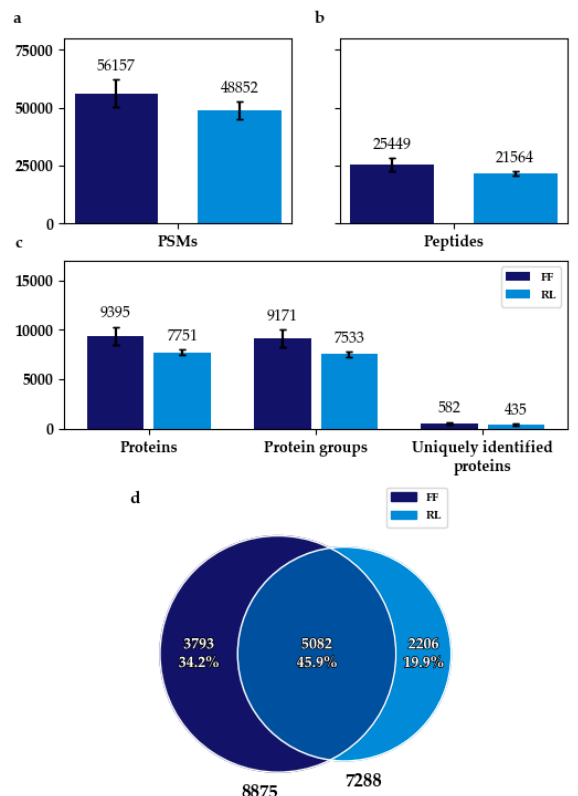
Figure 1. Identification rates and overlap of identified proteins of FF and RL stored samples. ( a ): Mean count of peptide-spectrum matches (PSMs); ( b ): Mean count of peptides identified, ( c ): Mean count of total number of proteins identified (Proteins), mean count of protein groups assembled by Scaffold (Protein groups), and mean number of proteins uniquely identified in one replicate (Uniquely identified proteins); ( d ): Overlap of bacterial proteins identified in at least two replicates in both storage conditions. Means are based on three replicates each. Error bars represent the standard deviation. FF: flash frozen; RL: RNAlater-treated.